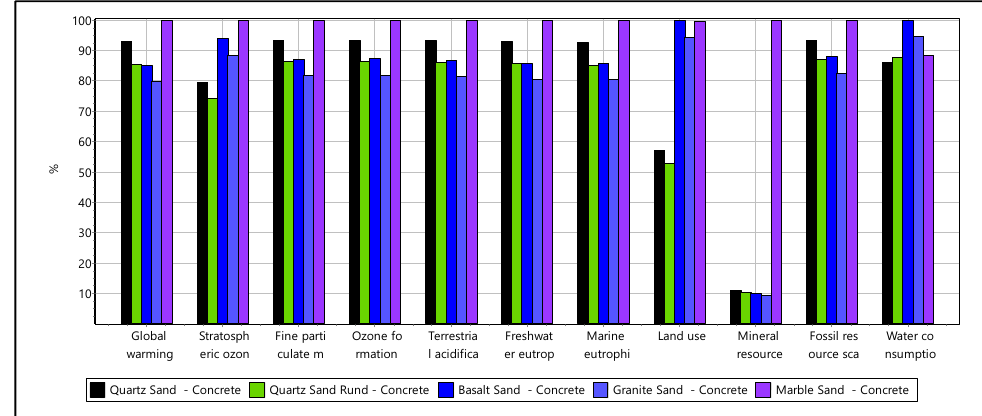
Figure 8. LCA comparison of primary raw material concrete samples across different impact categories.